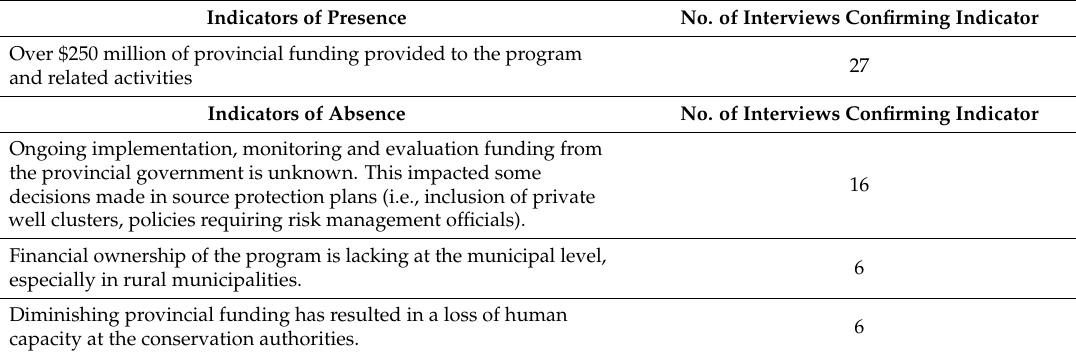
Table 5. Key Findings for Financial